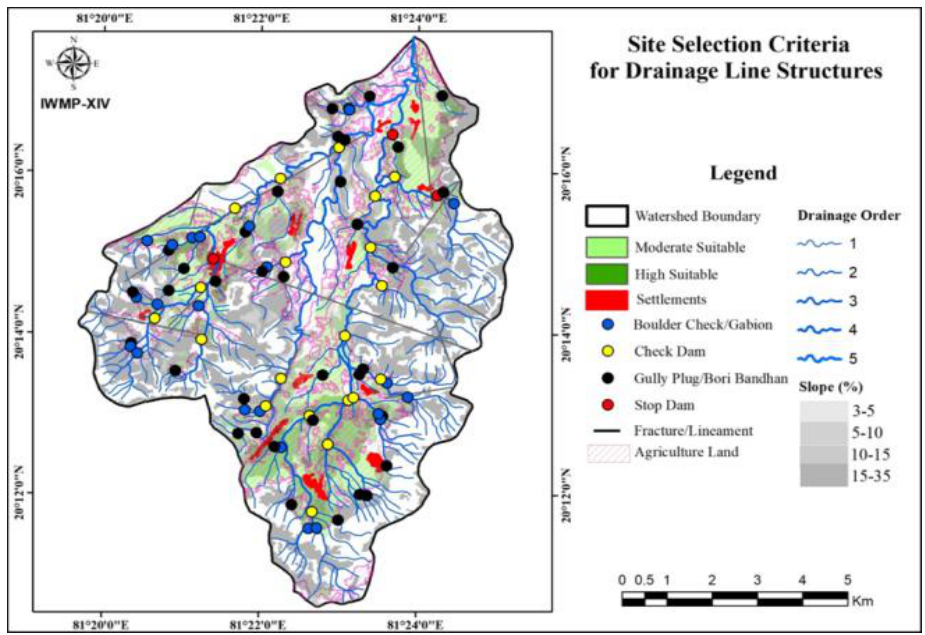
Figure 5: Suitable sites for drainage line